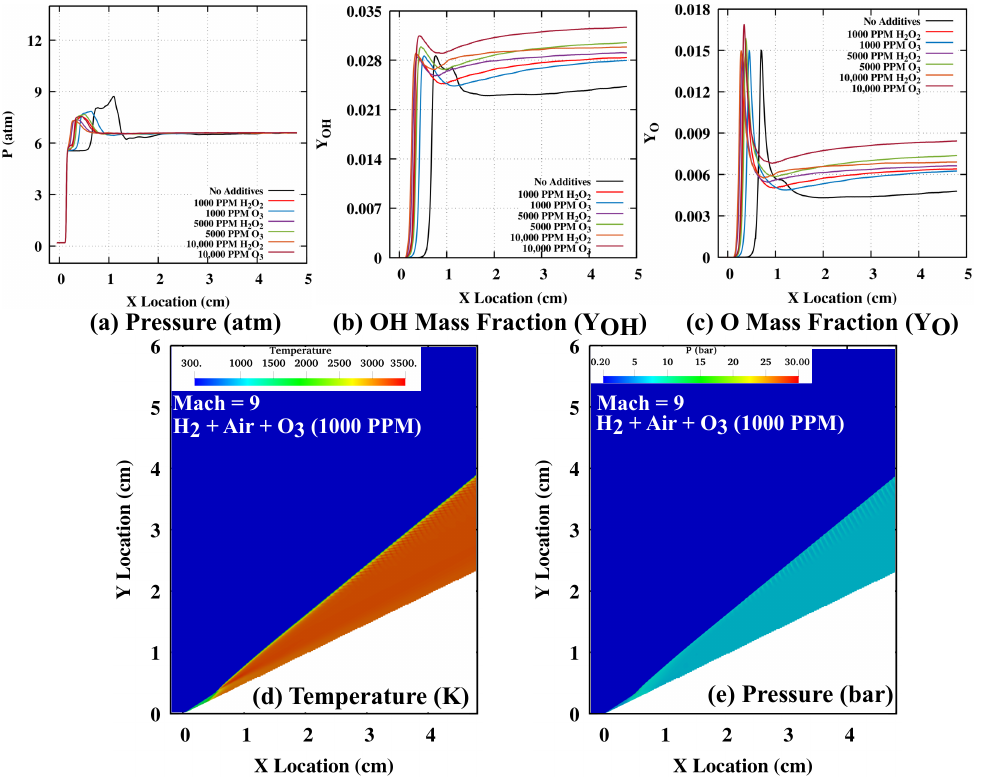
Figure 8. ( a ) Pressure, ( b ) OH Radical Mass fraction, ( c ) O variation along the wedge surface, ( d ) temperature and ( e ) pressure contour for 1000 PPM O 3 addition at Mach